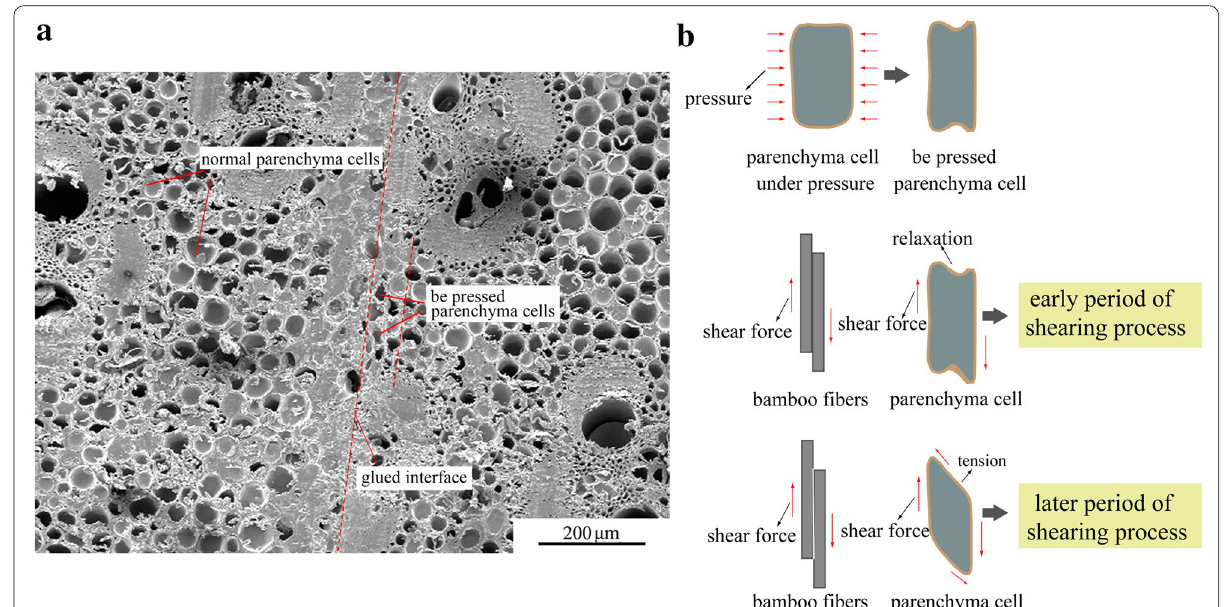
Fig. 9 a Morphology of interface of glued bamboo, b schematic drawing of shearing